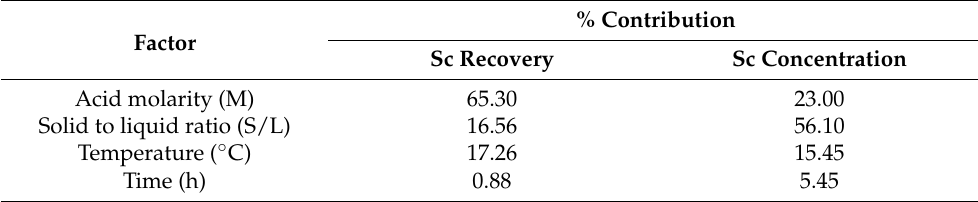
Table 3. % factors contribution for Sc recovery and